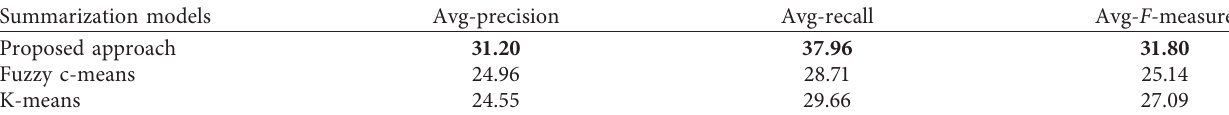
Figure 3: Evaluation of summarization models in respect of ROUGE-2 measures on Ubuntu dataset. Table 3: Evaluation of summarization models on various measures using ROUGE -1 on NYC dataset.